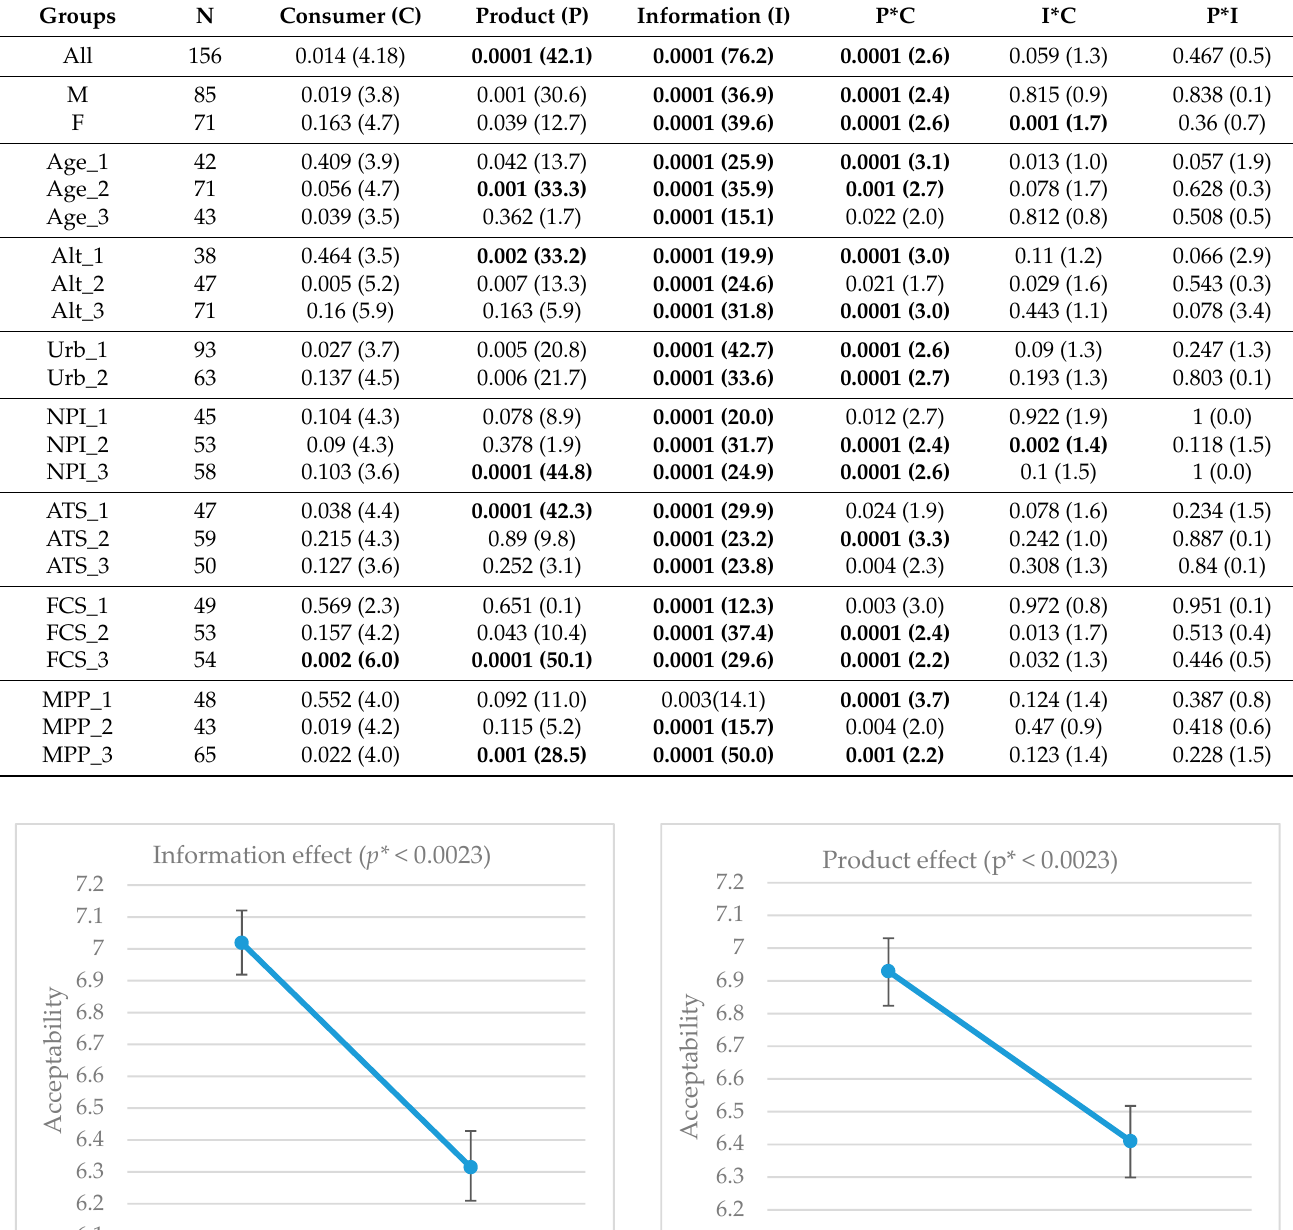
Table 7. The p -values of ANOVA mixed model on the effects of consumer, conjoint factors and their second order interactions (*) on liking. Mean squares are reported in parentheses. Statistically significant effects after Bonferroni correction ( p -value < 0.0022) are reported in bold.